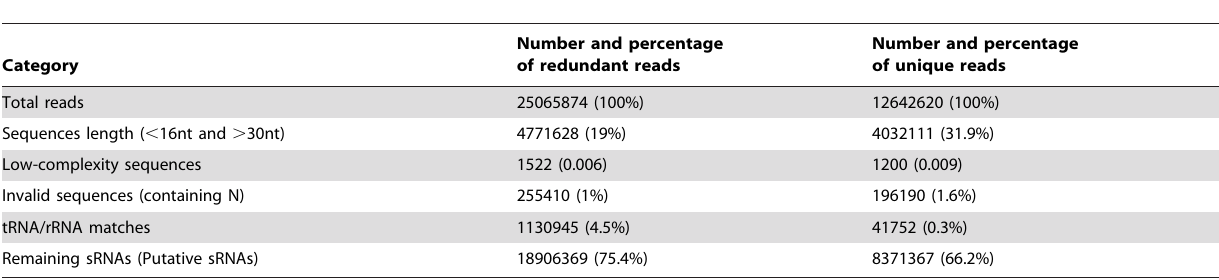
Table 1. Filtering of small RNA reads. Purity filtered sequences were processed through an elimination